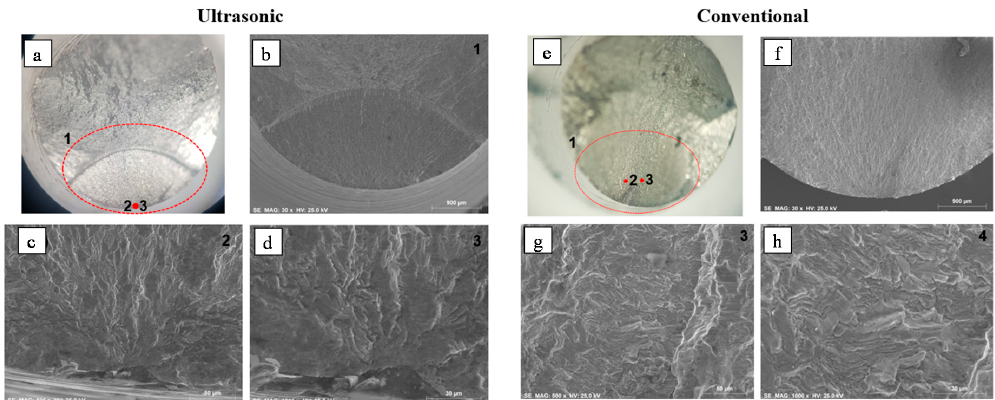
Figure 25. Multiaxial specimen after ultrasonic testing: ( a ) optical microscope general view; ( b ) SEM general view; ( c ) point of fatigue crack initiation (500 × ); (d) point of fatigue crack initiation (1000 × ). Multiaxial specimen after conventional testing: ( e ) optical microscope general view; ( f ) SEM general view; ( g ) fatigue propagation near initiation (500 × ); ( h ) fatigue propagation near initiation (1000 × ).